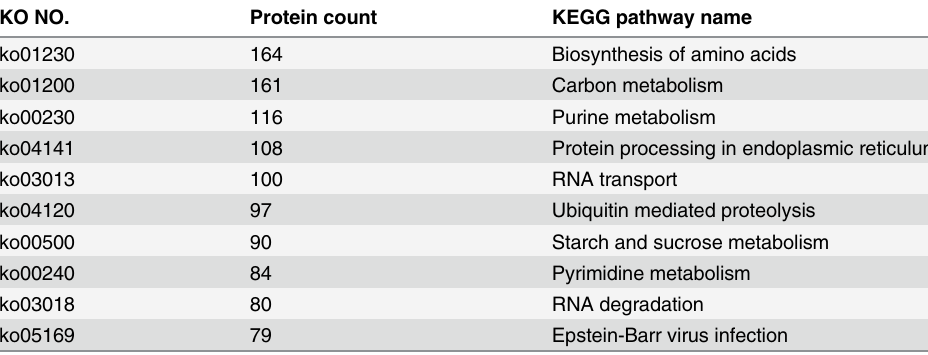
Table 4. The top 10 KEGG pathways with most protein sequences. KO NO.